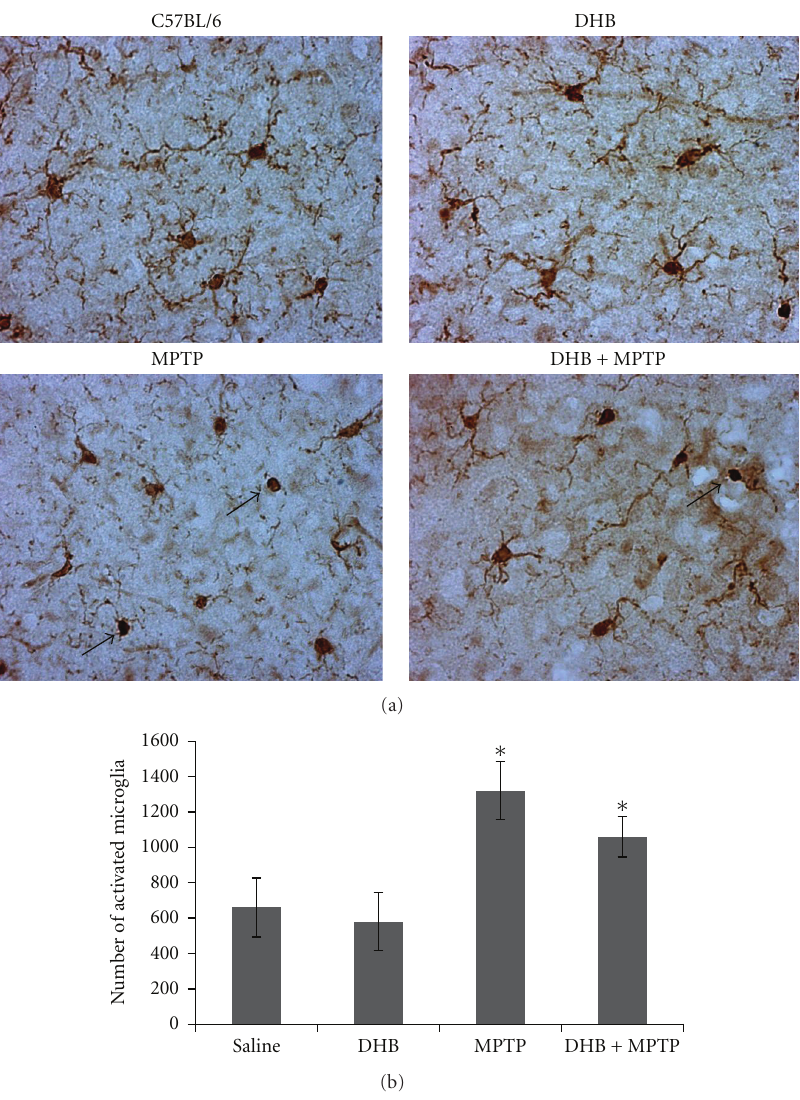
Figure 8: Iba1 immunostaining of SN sections of mice treated with either saline (Control), DHB, MPTP or DHB + MPTP. (a) Microglia in MPTP-treated mice display a morphological transformation from resting ramified microglia to activated amoeboid like forms with withdrawn processes (indicated by arrows) which is inhibited in the presence of DHB treatment. (b) MPTP treatment leads to a significant increase in the number of activated microglia relative to saline and DHB treated mice. Activated microglia were bilaterally counted under a 40x objective. Data are means ± SEM for 4 mice per group, ∗ P < 0 . 05 compared to saline